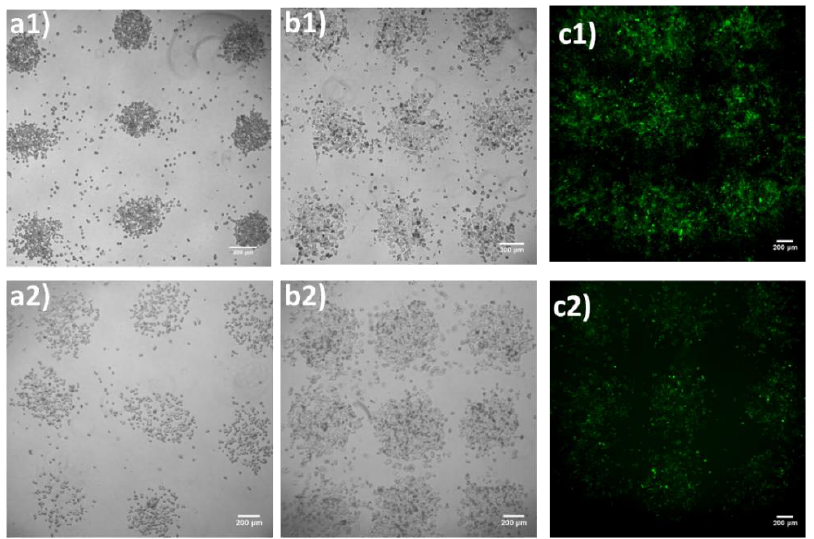
Figure 7. Bright-field (BF) optical microscopy images of LIFT-printed MDA-MB-468-H2B-GFP at 0 h, 4- and 6-days post-printing, at 360 (( a1 – c1 ) at 532 nm) and 330 mJ/cm 2 (( a2 – c2 ) at 355 nm), respectively. Scale bar 200 μ m.